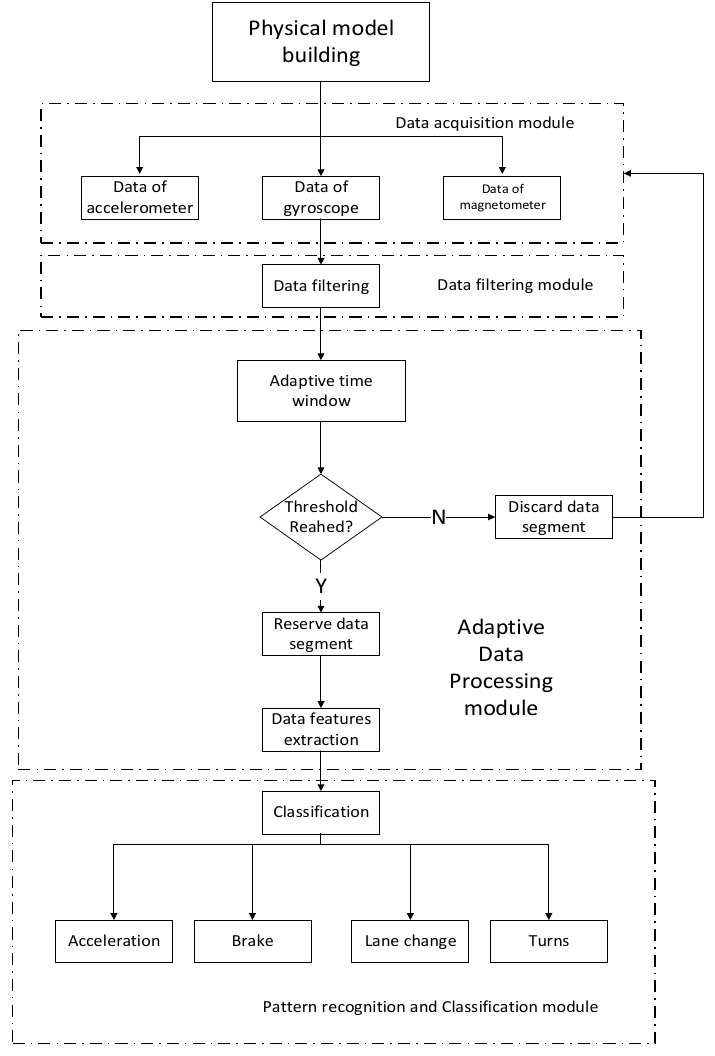
Figure 3. Architecture of proposed driving behavior recognition system.